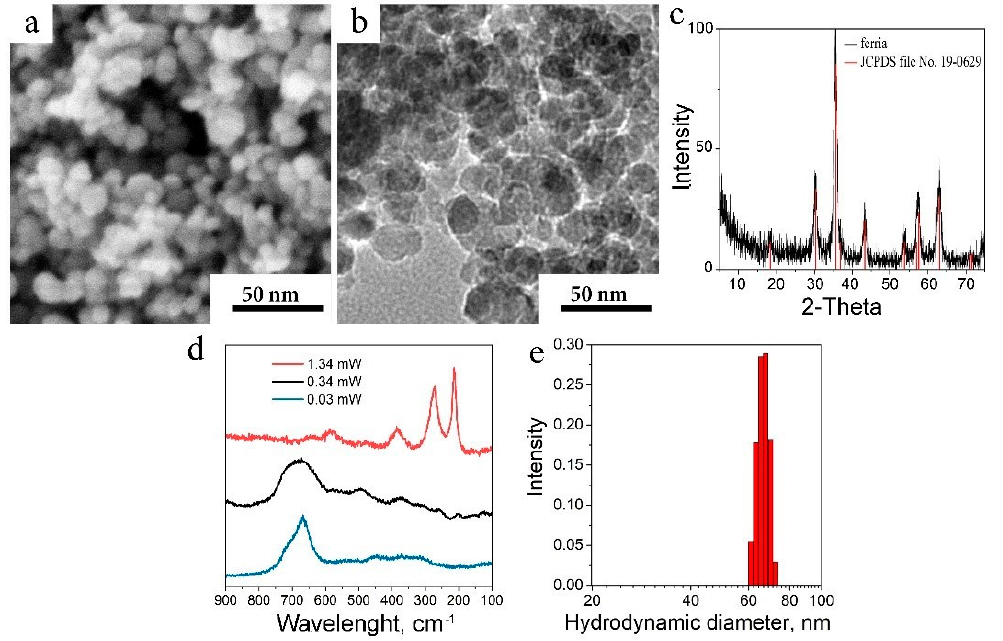
Figure 1. Characterization of the MNPs. ( a ) SEM image of MNPs; ( b ) TEM image of MNPs; ( c ) XRD pattern of MNPs compared to JCPDS file No. 19–0629; ( d ) Raman spectra of MNPs collected at various laser beam intensity; ( e ) DLS analysis of MNPs.